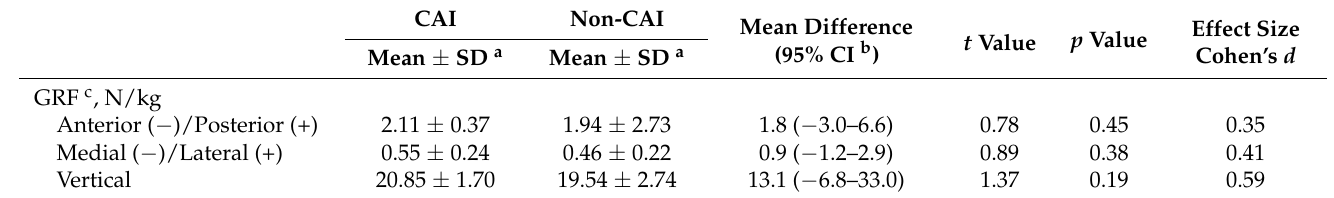
Table 2. The maximum values of the peak GRF components of the CAI and the non-CAI groups. CAI